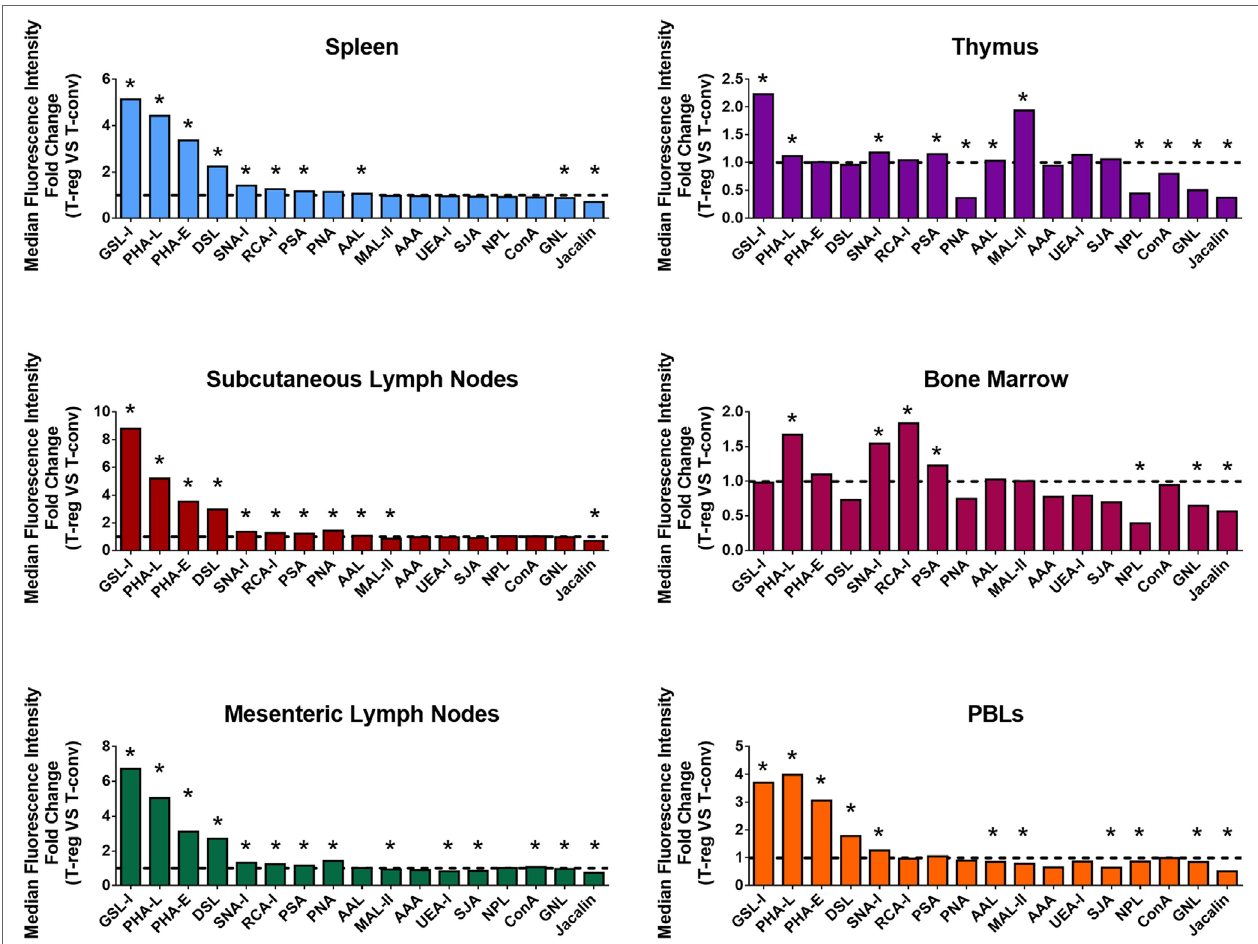
FigUre 1 | Differential surface lectin-binding intensities of Treg and CD4 + Tconv from various immunological niches in healthy mice . Surface glycosylation of freshly isolated CD4 + T-cells from C57BL/6 FoxP3.EGFP mouse spleen, subcutaneous lymph nodes, mesenteric lymph nodes, thymus, bone marrow, and peripheral blood leukocytes (PBLs) was evaluated by lectin profiling using flow cytometry as described in the Section “Materials and Methods.” Results are presented as the fold change in median fluorescence intensity (MFI) of lectin binding between Treg and Tconv ( n = 4–8 individual animals). Line at y = 1 represents the value at which the lectin-binding intensities are the same for Treg and CD4 + Tconv. Statistical analysis was performed by permutation test with a paired design (* p value ≤